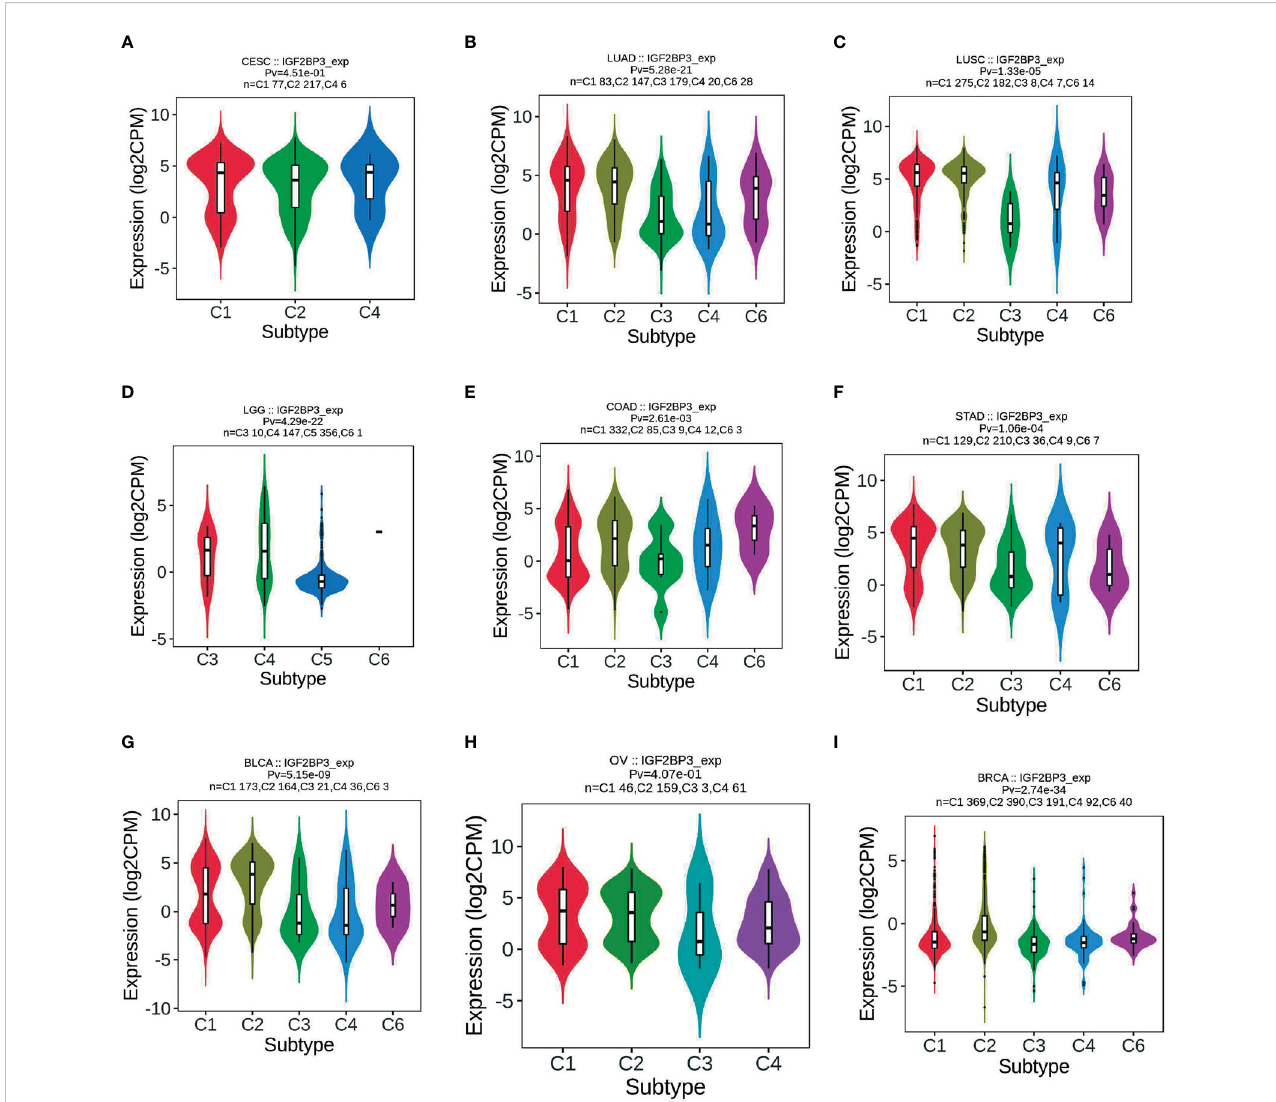
FIGURE 7 Correlations between IGF2BP3 expression and immune subtypes across TCGA tumors. (A) CESC; (B) LUAD; (C) LUSC; (D) LGG; (E) COAD; (F) STAD; (G) BLCA; (H) OV; (I)